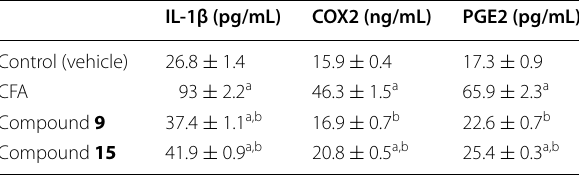
Data represent the mean a Significance versus control (P b Significance versus CFA group (P